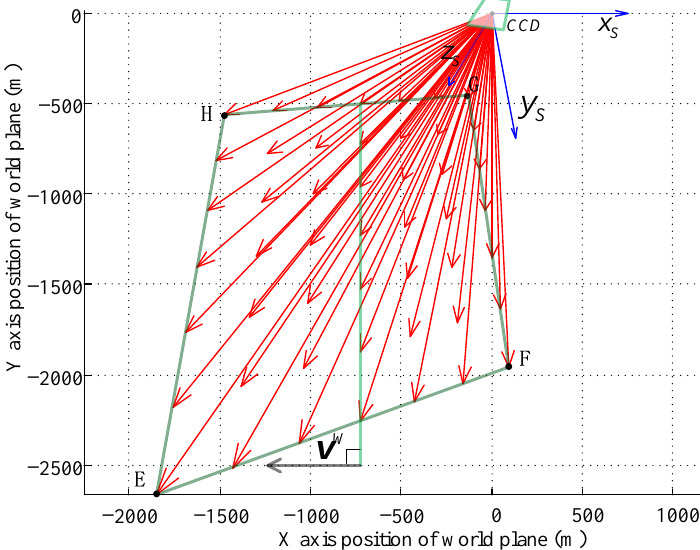
Figure 7. Ground imaging area and primary light distribution. The variation of the IMLV on the sensor plane will degrade the image motion ’s compensation performance, so it is necessary to study the variation laws of the maximum deviation of the IMLV. The variations of the maximum deviation of the IMLV with the target roll and pitch angles are shown in Figure 8. The parameters were the same as those in Figure 6, except for the target roll angle and target pitch angle. Φ T increased from − 30 ◦ to − 5 ◦ , while Θ T = − 5 ◦ . Θ T increased from − 30 ◦ to − 5 ◦ , while Φ T = − 5 ◦ . The magnitude of the maximum deviation of the IMLV would increase with | Φ T | or | Θ T | . The absolute value of the phase angle of the maximum deviation of the IMLV would increase with | Φ T | but decrease when | Θ T | increased. The attitude of the camera provided by the POS had measuring error; the azimuth, pitch, and roll measuring errors were 0.08 ◦ , 0.05 ◦ , and 0.05 ◦